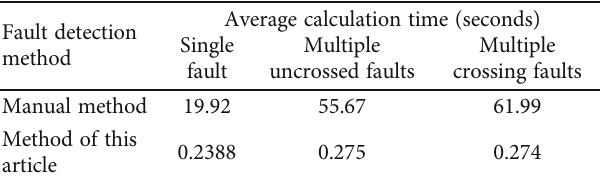
Table 1: Comparison of the average time consumption of tomographic detection.